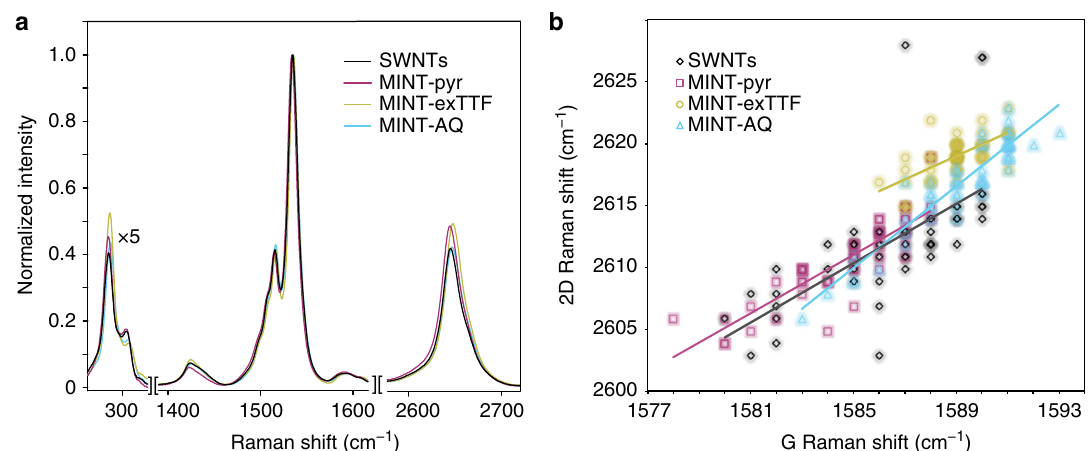
Fig. 2 Raman spectroscopy. a Average ( N = 50) Raman spectra of SWNT (black), MINT-exTTF (yellow), MINT-pyr (purple), and MINT-AQ (cyan). b Plot of the Raman shift of 2D band vs G band for each of the 50 different spectra ( λ exc = 532 nm) of SWNT (black rhombi), MINT-exTTF (yellow circles), MINT-pyr (purple squares), and MINT-AQ (cyan triangles), data points are shaded to indicate the frequency